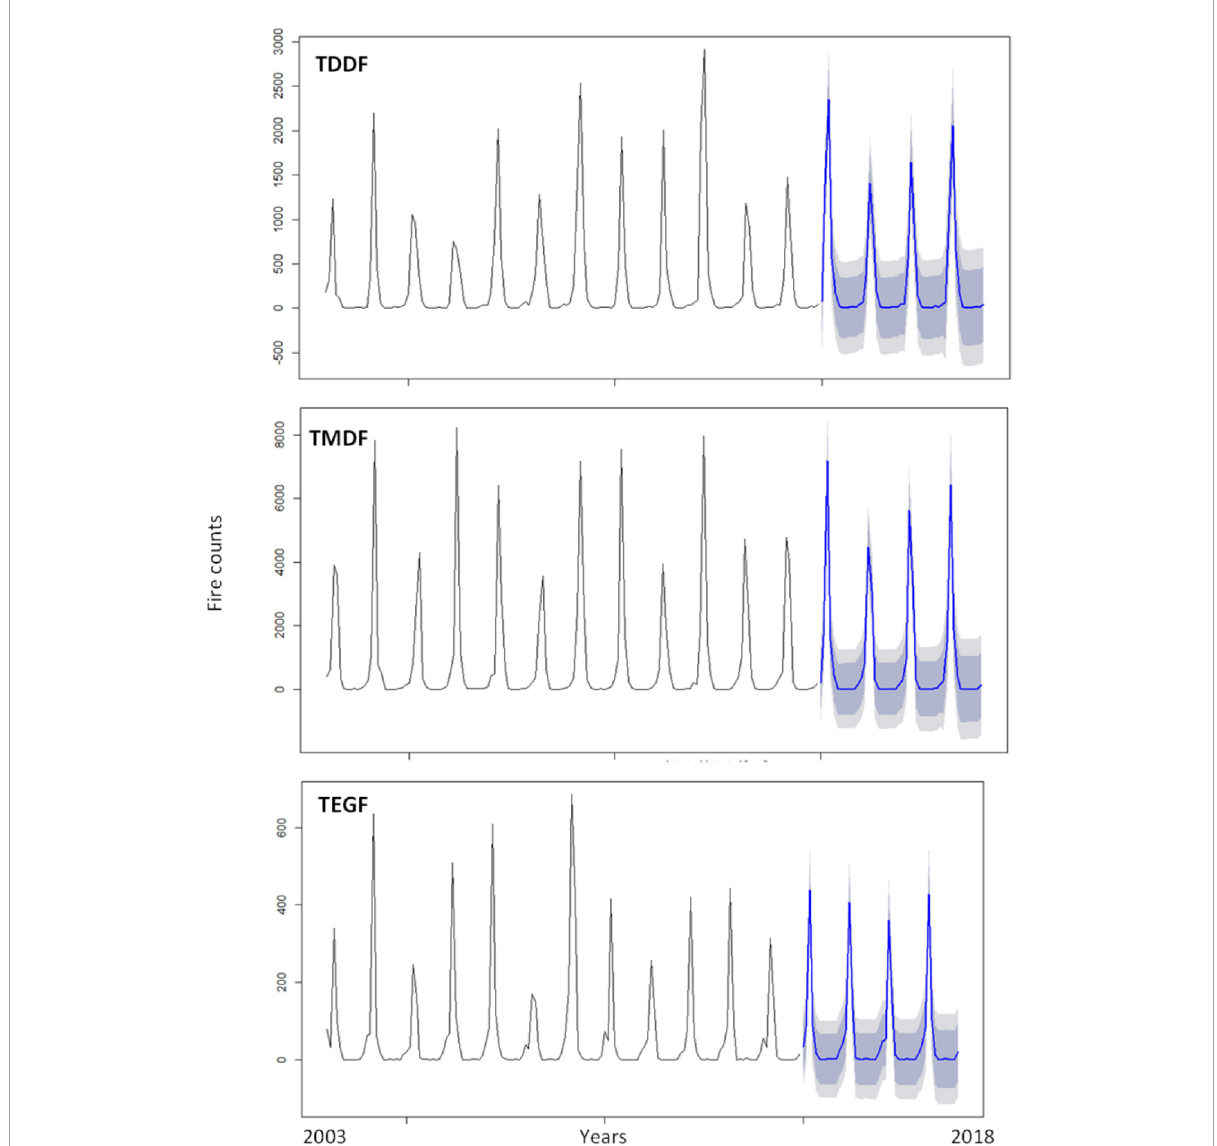
FIGURE6 Forest fire forecasting based on ARIMA univariate model for Tropical Dry Deciduous Forests (TDDF) Tropical Moist Deciduous Forests (TMDF) and Tropical Evergreen Forests (TEGF). Blue lines depict forecasted fires and shaded area depicts prediction interval (inner to outer 80 and 95%,